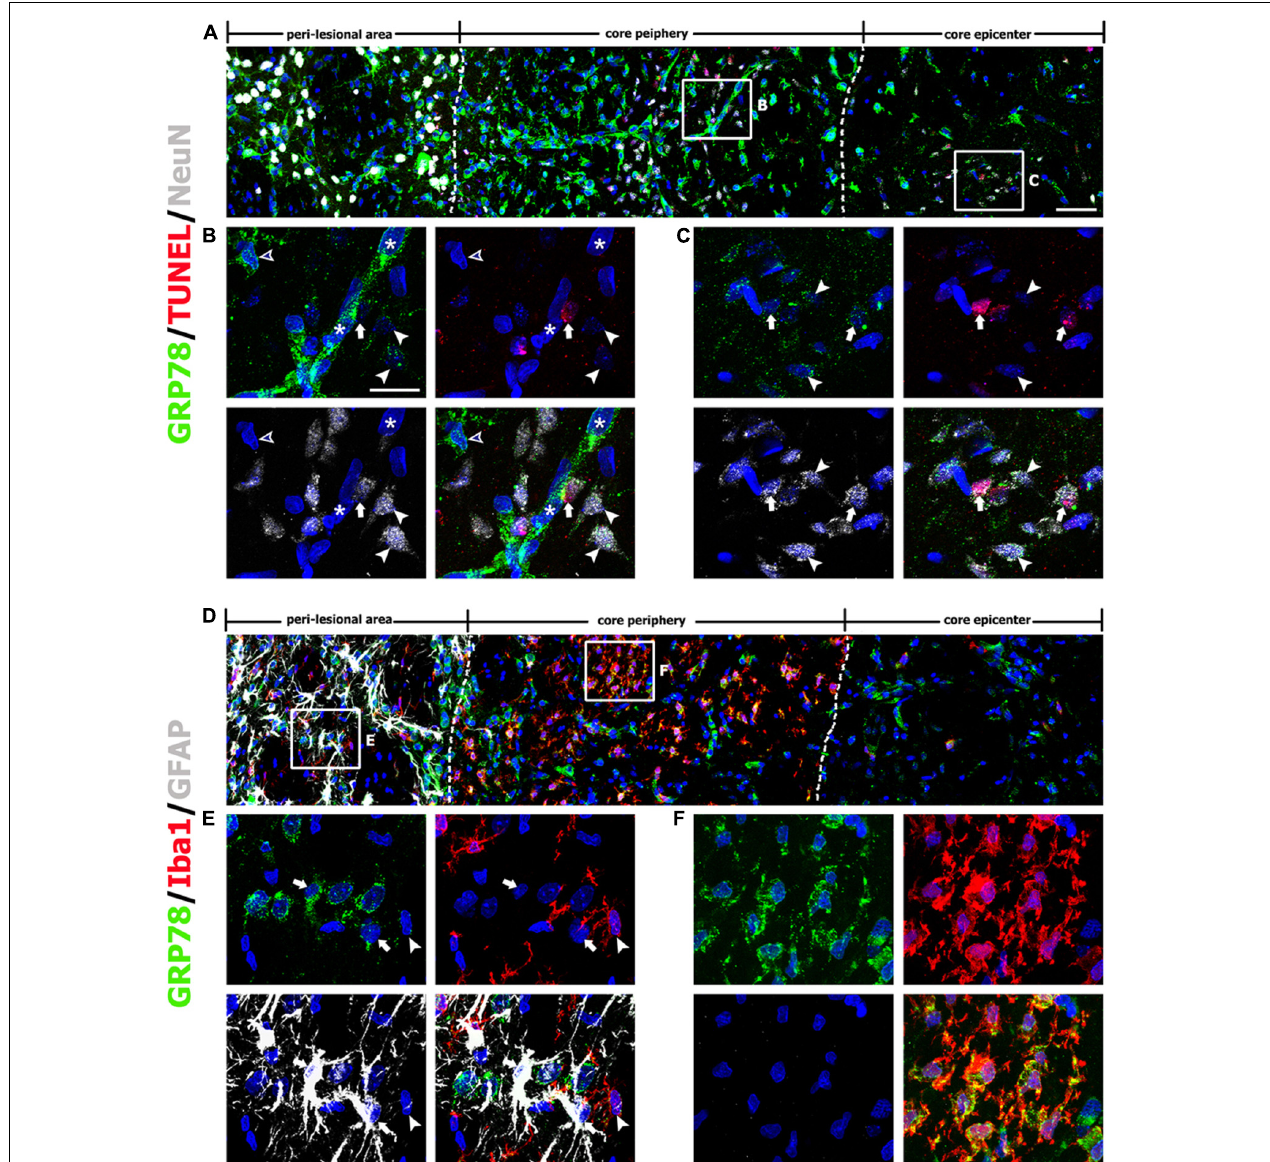
FIGURE 3 | Characterization of glucose-regulated protein (GRP78)-positive cells in lesioned striatum on day 3 after 3-nitropropionic acid injection. (A) Triple-labeling of GRP78, NeuN, and terminal deoxynucleotidyl transferase dUTP nick end labeling (TUNEL) showing that neuronal GRP78 expression is evident in the perilesional area, while GRP78 is virtually absent in dying or dead neurons in the lesion core. The two broken lines indicate the borders of three areas: the peri-lesional area, lesion periphery, and epicenter. The corresponding boxed areas in the lesion periphery and epicenter in A are enlarged in B , C . (B,C) In both the lesion periphery (B) and the epicenter (C) , both TUNEL-positive (arrows) and TUNEL-negative (arrowheads) neurons show negligible immunoreactivity. Notably, in the lesion periphery, intense GRP78 expression is localized within the vascular profiles (asterisks in B ) and presumptive activated microglia (open arrowheads in B ), while no specific GRP78 expression is detectable in the epicenter. (D) Triple-labeling of GRP78, Iba1, and GFAP showing that the lesion core can be divided into two areas: the core periphery, which is heavily infiltrated by activated microglia, and the epicenter, which is devoid of Iba1-positive microglia. Notably, GFAP immunoreactivity is absent in both the periphery and the epicenter. (E,F) Higher-magnification views of the corresponding boxed areas in D . (E) In the peri-lesional area, GRP78 expression can be observed in reactive astrocytes (arrows) and activated microglia (arrowheads). (F) In the lesion periphery, intense GRP78 expression is visible in almost all Iba1-positive cells. Cell nuclei are stained with 4 (cid:48) ,6-diamidino-2-phenylindole. Scale bars represent 50 µ m for A D ; and 20 µ m for B , C , E , F